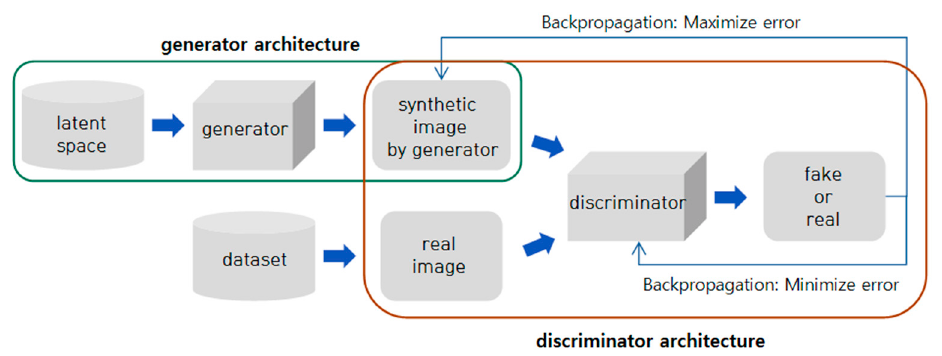
Figure 5. Architecture of the general adversarial network (GAN).